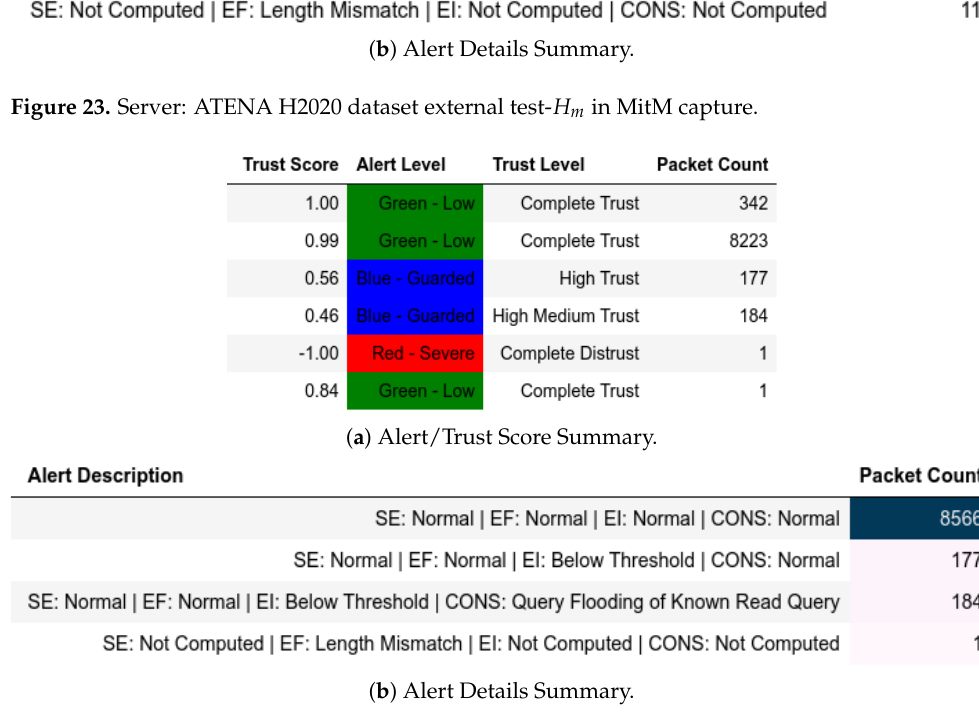
Figure 24. Server: ATENA H2020 dataset external test- H m in query flooding